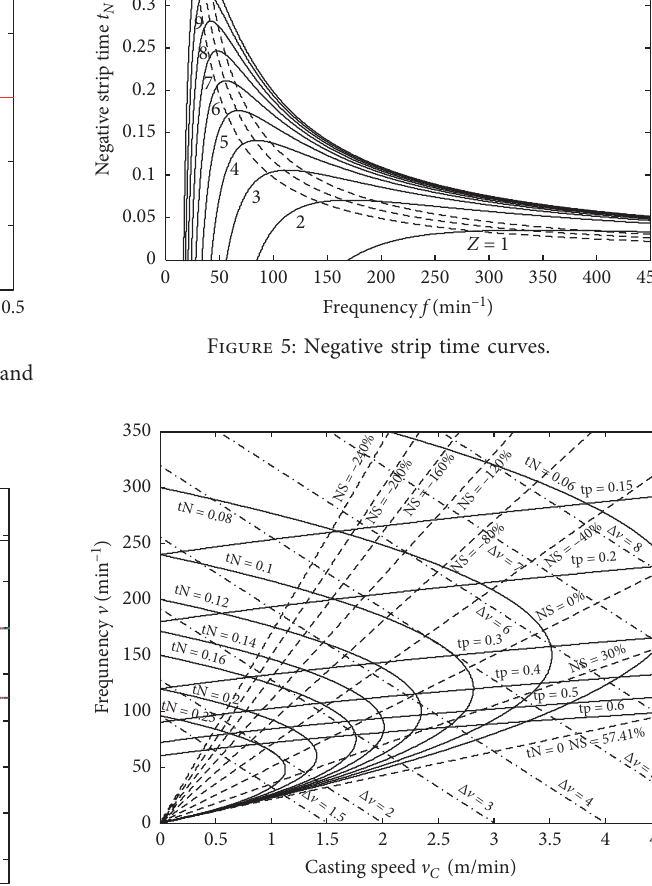
Figure 6: Multiparameter curves of nonsinusoidal oscillation with α � 20% and h �